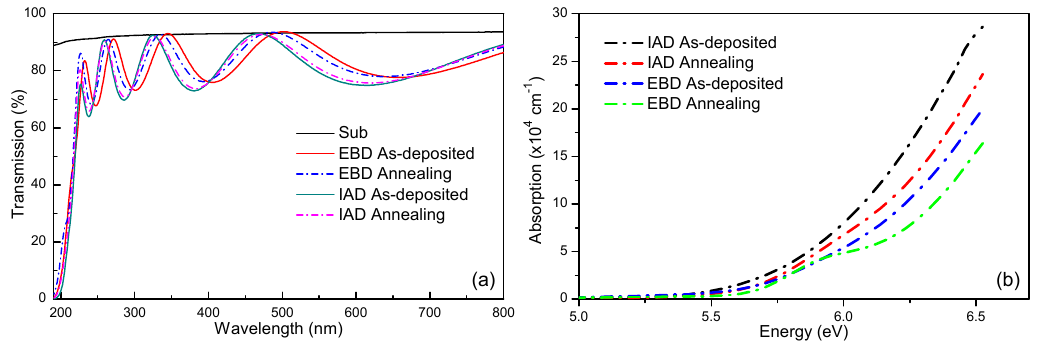
Figure 1. ( a ) The transmission of the prepared HfO 2 film samples and the substrate; ( b ) The